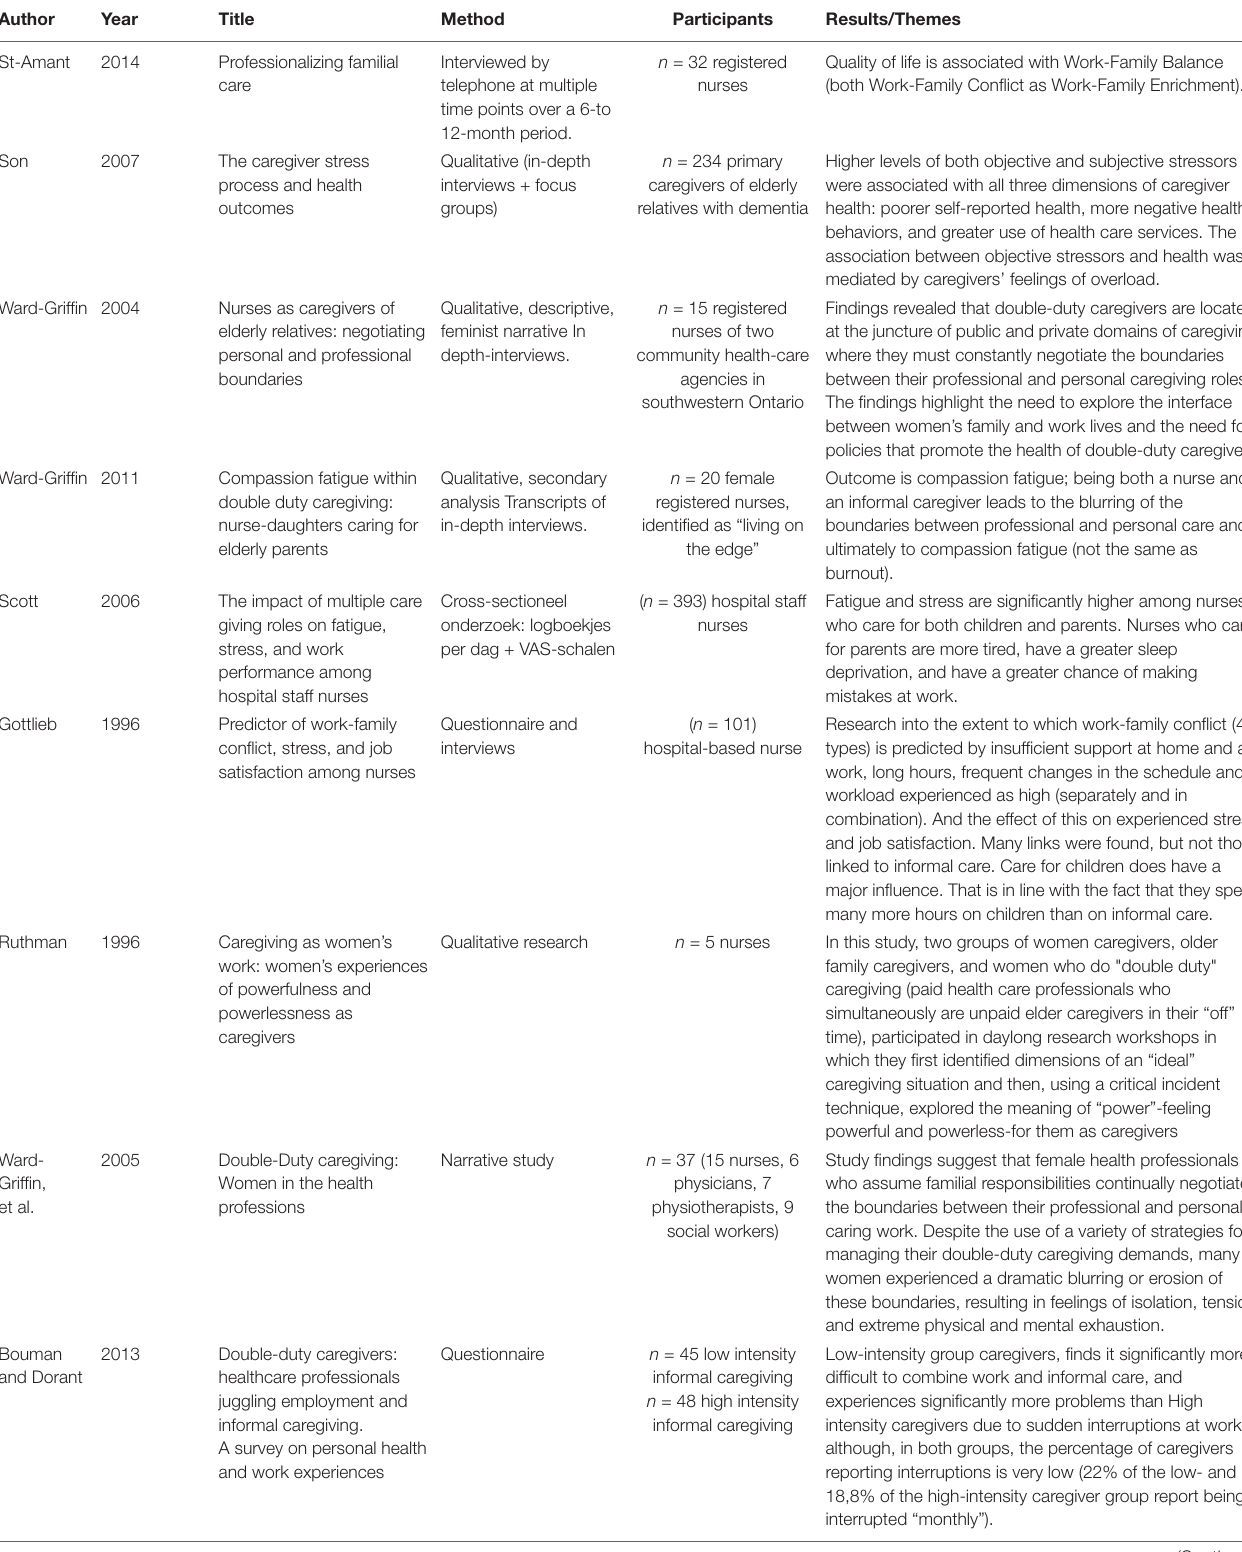
TABLE 1 | Overview of included articles ( N =